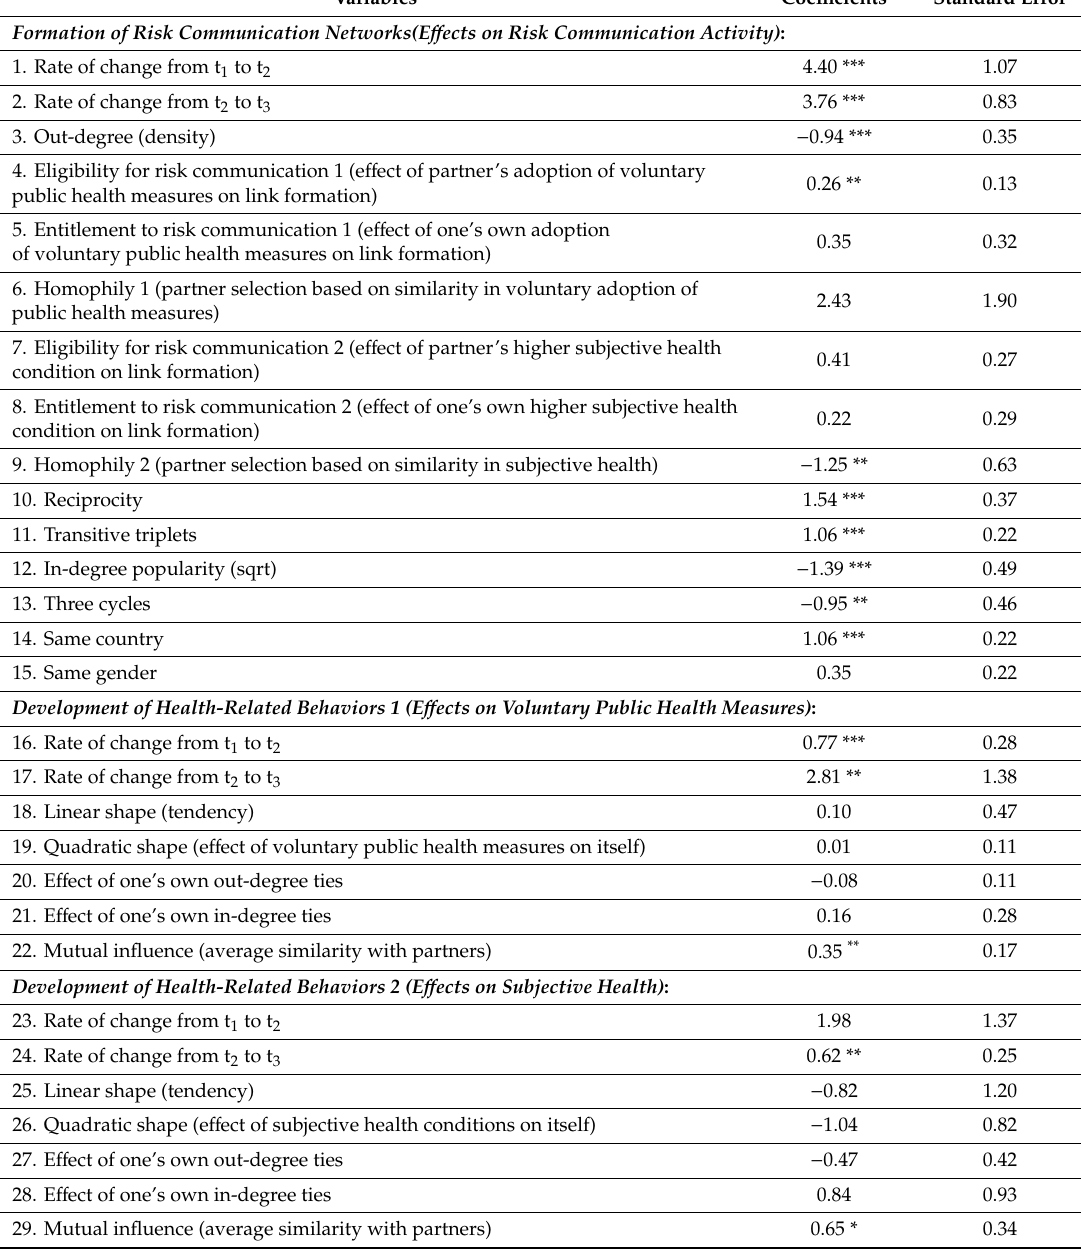
Table 1. Estimated Results for the Interactions between Risk Communication Networks and Health-related Behaviors across Three Subsequent